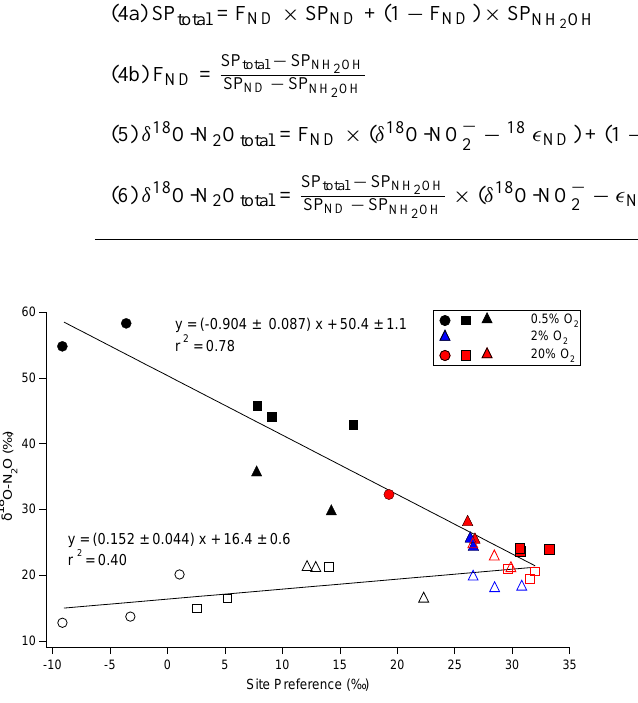
Fig. 5. Pathway dependence of δ 18 O-N 2 O and SP. Filled sym- bols are data from cultures grown in labeled water (about 40‰) while open symbols are data from cultures in unlabeled water (about − 5‰). Circles correspond to cultures with cell densities of 1 . 5 × 10 6 cells ml − 1 , squares to 2 × 10 5 cells ml − 1 , and triangles to 2 . 1 × 10 4 cells ml − 1 . Colors correspond to headspace O 2 lev- els, with black symbols representing 0.5% O 2 , blue symbols 2% O 2 , and red symbols 20% O 2 . Regression slopes and intercepts are given ± one standard deviation. Data from low-density cultures were not included to avoid the impact of relaxation of the δ 18 O- NO − towards equilibrium with H 2 O over the course of the NH 3 2 oxidation reaction. Data points that were less than 1nmol N 2 O were not included. All δ 18 O values are referenced to